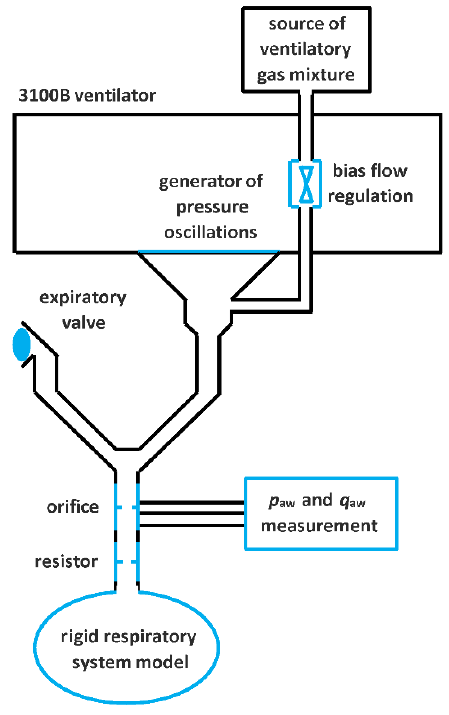
Figure 1. Setup of in vitro experiment [24].